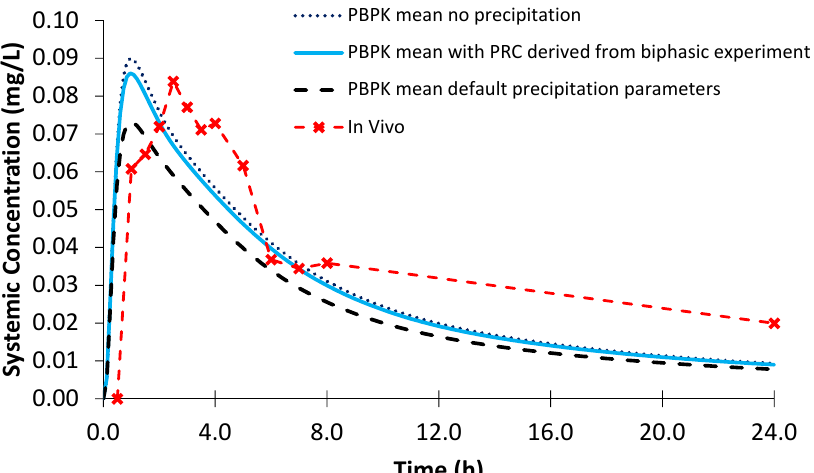
Figure 13. Simulated plasma profile vs. in vivo plasma profile (dashed line with crosses) of itraconazole solid dosage form after a single oral dose of itraconazole 200 mg, based on the design of the clinical study by Brouwers et al. [24]. The in vivo plasma profile is represented by the red dashed line with crosses. The simulated plasma profile derived from the biphasic dissolution data, the PBPK default simulator parameters and the profile without precipitation are represented by the solid blue line, the dashed black line and dotted dark blue line, respectively.